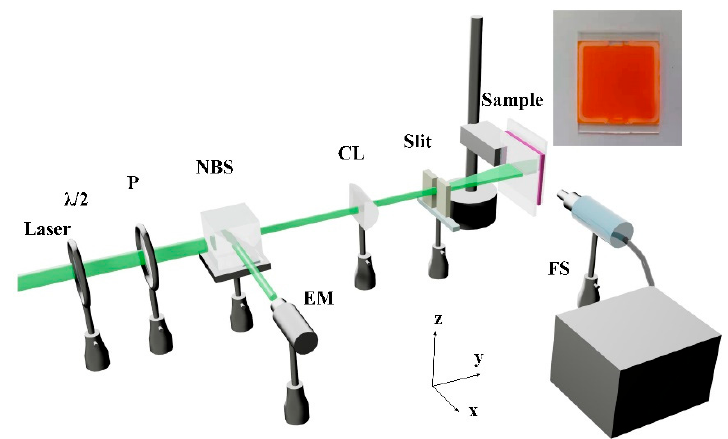
Figure 1. The schematic diagram of the experimental setup. The inset is the optical photograph of the sample. λ /2, P, NBS, CL, EM, and FS express the half-wave plate, polarizer, neutral beam splitter, cylindrical lens (focal length of 10 cm), energy meter, and fiber spectrometer, respectively.